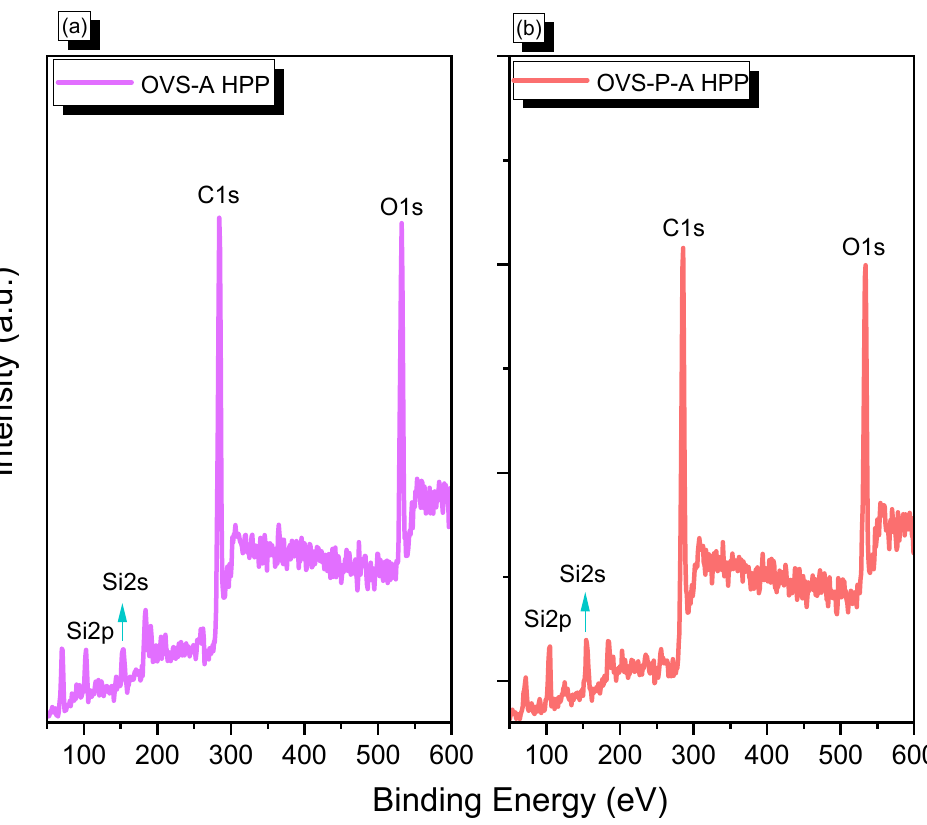
Figure 2. XPS analysis of ( a ) OVS-A HPP and ( b ) OVS-P-A HPP. TGA analysis was used to measure the thermal stability and char yield of OVS-A HPP and OVS-P-A HPP (Figure 3). The thermal decomposition temperatures (T d5 , T d10 ) and char yield for OVS were observed as 240 °C, 255 °C, and 4 wt%, respectively. The corresponding values for A-Br 2 were 219 °C, 234 °C, and 0 wt%, whereas those for P-Br 4 were 321 °C, 350 °C, and 0 wt%, respectively. We found that the developed hybrid porous material’s thermal stability and char yield were greatly enhanced after the heck reaction, due to the cross-linking of OVS with A-Br 2 and P-Br 4 / A-Br 2 . The OVS-A HPP experienced a thermal stability of (T d5 , T d10 ) 473 °C, 579 °C, and a char yield of 83 wt%; meanwhile, for OVS-P-A HPP, they were 317 °C, 377 °C, and 73 wt%, respectively. The thermal stability and char yield of OVS-A HPP was higher than that of OVS-P-A HPP due to its higher cross-linking density. The thermal properties of two hybrid porous materials are summa- rized in Table 1.